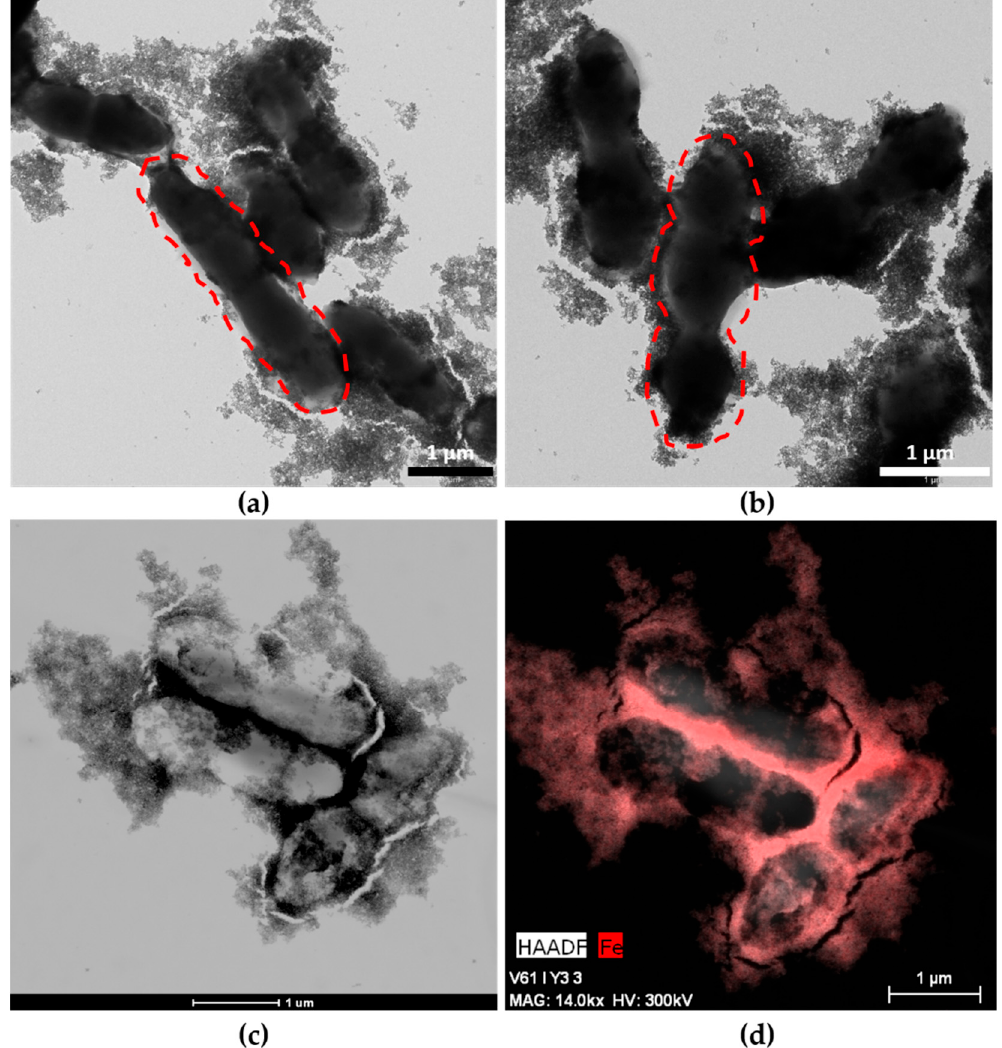
Figure 1. Maghemite nanoparticles (MNPs)–ferment observed by TEM and High-Angle Annular Dark Field-Scanning Transmission Electron Microscopy (HAADF-STEM): ( a ) TEM image of MNPs–ferment showing the presence of Lactobacillus acidophilus (dashed lines) with MNPs adhered to the exopolysaccharides (EPS); ( b ) TEM image of MNPs–ferment showing the presence of Streptococcus thermophilus (dashed lines) with MNPs adhered to the EPS; ( c ) HAADF-STEM image of the MNPs– ferment sample; and ( d ) EDX map of the MNPs–ferment sample with iron highlighted in red.